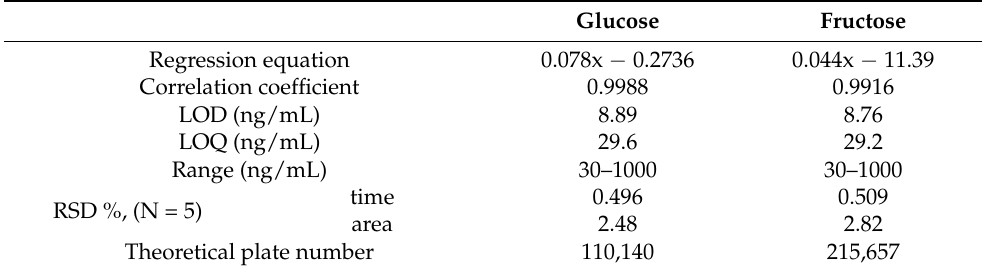
Table 1. Analytical performance data of fructose and glucose. The analysis conditions were the same as stated at Figure 2B.